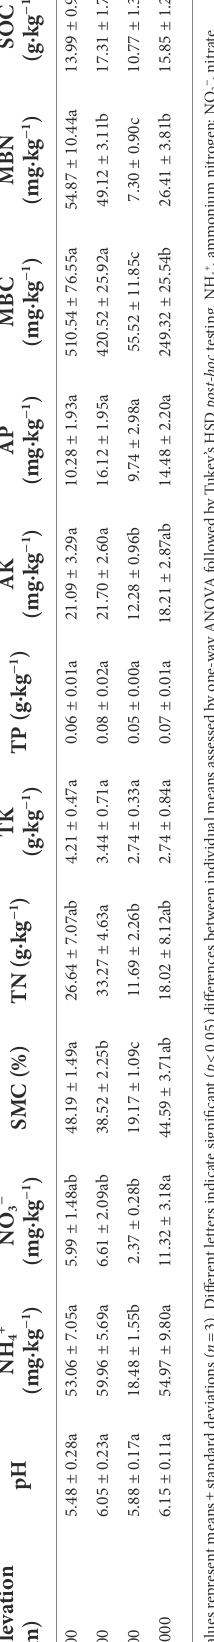
TABLE 2 Bacterial α diversity in the soil collected at different altitudes.